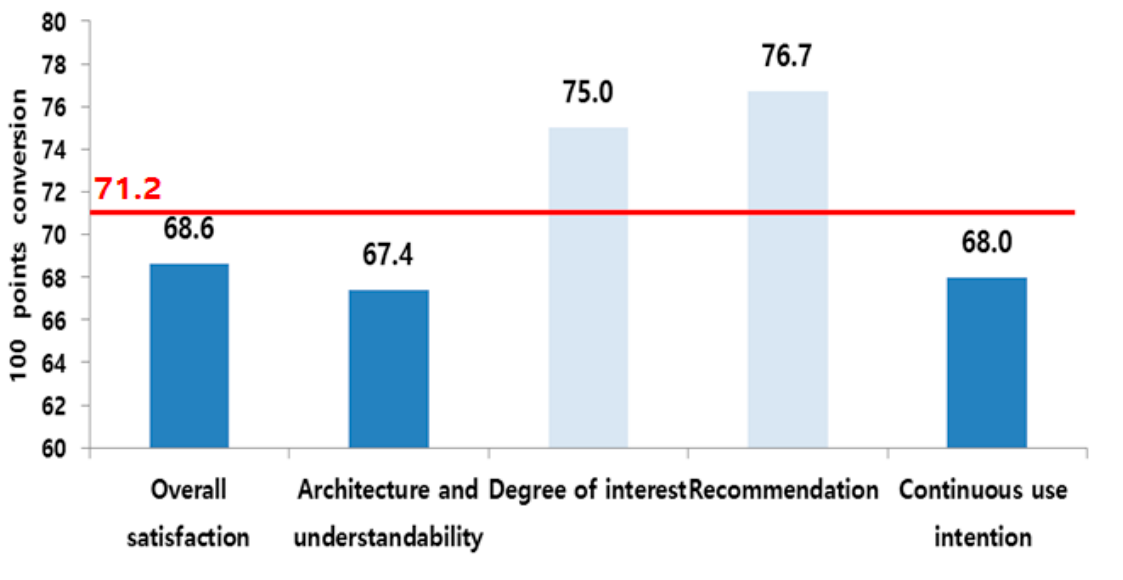
Figure 5. Satisfaction item scores (converted to a scale of 100).